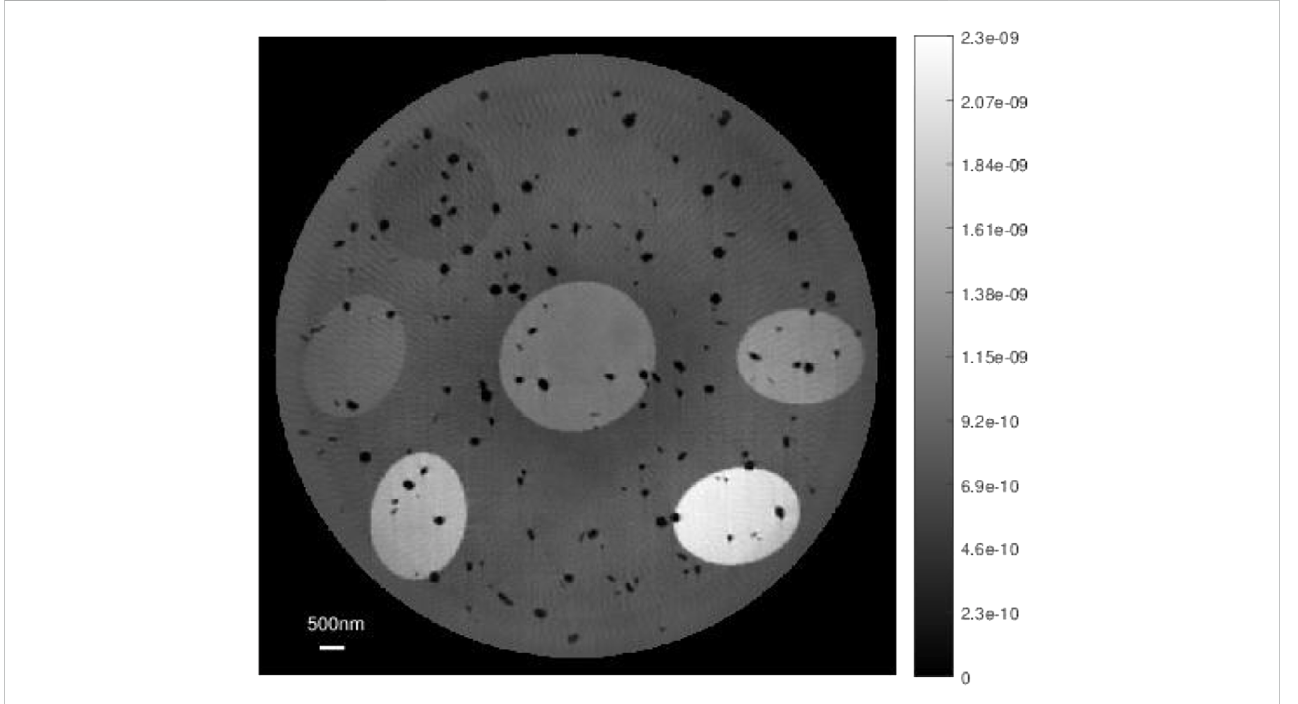
FIGURE 13 The inversion result using PRM for noisy data with noise-level 1%.